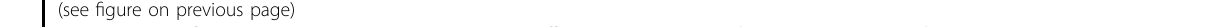
Fig. 6 miR-6780b-5p promotes EMT in ovarian cancer cells. a qRT-PCR was used to compare miR-6780b-5p expression among 18 ADEs with peritoneal metastasis and nine without peritoneal metastasis. ★ , #7 ADEs. b Kaplan – Meier analysis of miR-6780b in pancancer analysis with K-M Plotter. c qRT-PCR was used to compare miR-6780b-5p expression in four ovarian cancer cell lines. d qRT-PCR was used to compare the relative miR- 6780b-5p expression in four sets of ADEs (#6, #12, #21, #25) from four HGSOC patients. e Western blots of E-cadherin, N-cadherin and Vimentin expression in A2780, CAOV3, ES2, and SKOV3 cells treated with four sets of ADEs with different miR-6780b-5p concentrations. f qPCR validation of the effects of the miR-6780b-5p agomir and antagomir in A2780, CAOV3, ES2, and SKOV3 cells. g Representative images of in vitro wound-healing and transwell migration assays with SKOV3 and ES2 ovarian cancer cells after transfection of miR-6780b-5p stable NC/agomir and inhibitor NC/antagomir. Scale bar for the wound-healing assay, 100 μ m. Scale bar for the transwell assay, 100 μ m. h The areas of wound closure and the numbers of migrating cells in transwell migration assays were measured and are shown as histograms. i Western blot analysis of the expression of E-cadherin, N-cadherin, and Vimentin in A2780, CAOV3, ES2, and SKOV3 cells after transfection with miR-6780b-5p agomir and antagomir. Experiments were performed in at least triplicate, and the results are shown as the mean ± s.d. values. Student ’ s t test was used to analyze the data (NS, not signi fi cant; * p < 0.05; ** p < 0.01; *** p <